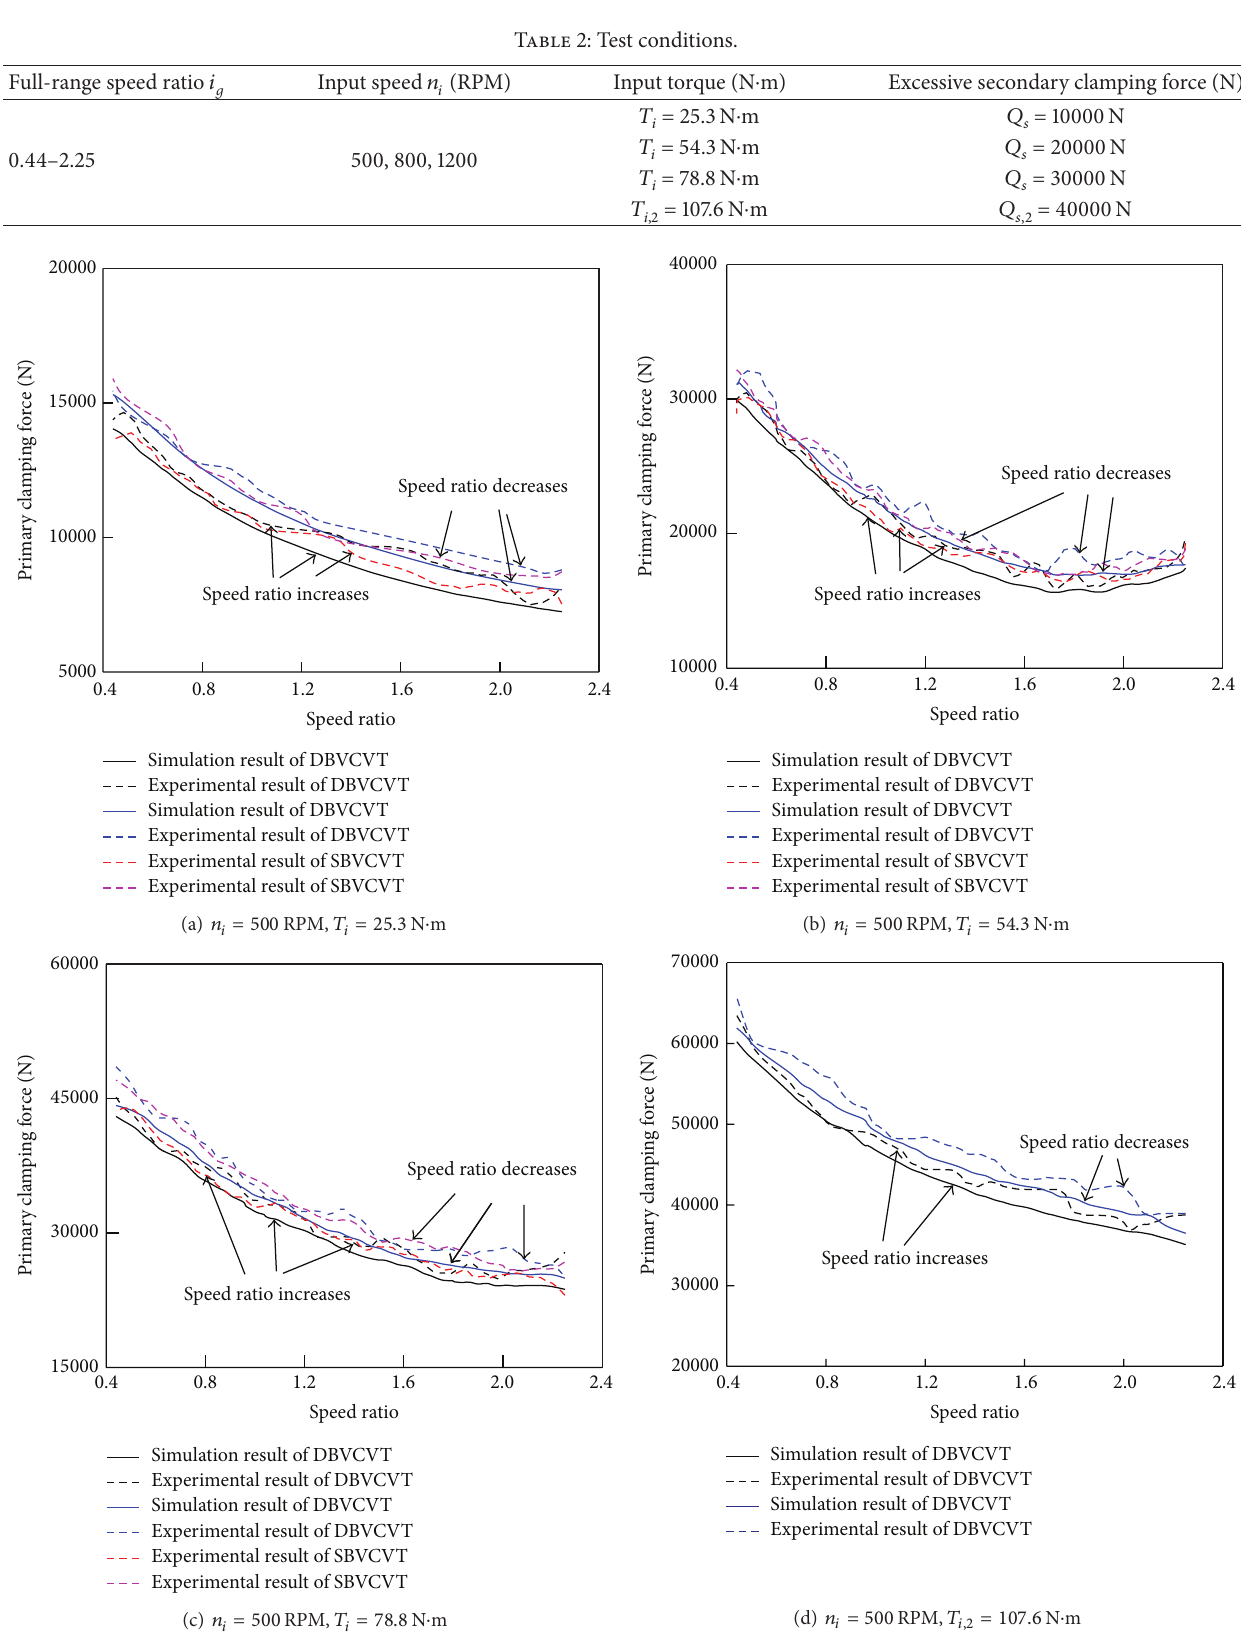
Figure 7: Comparison of simulation and experimental results of speed ratio responses under 𝑛 𝑖 = 500